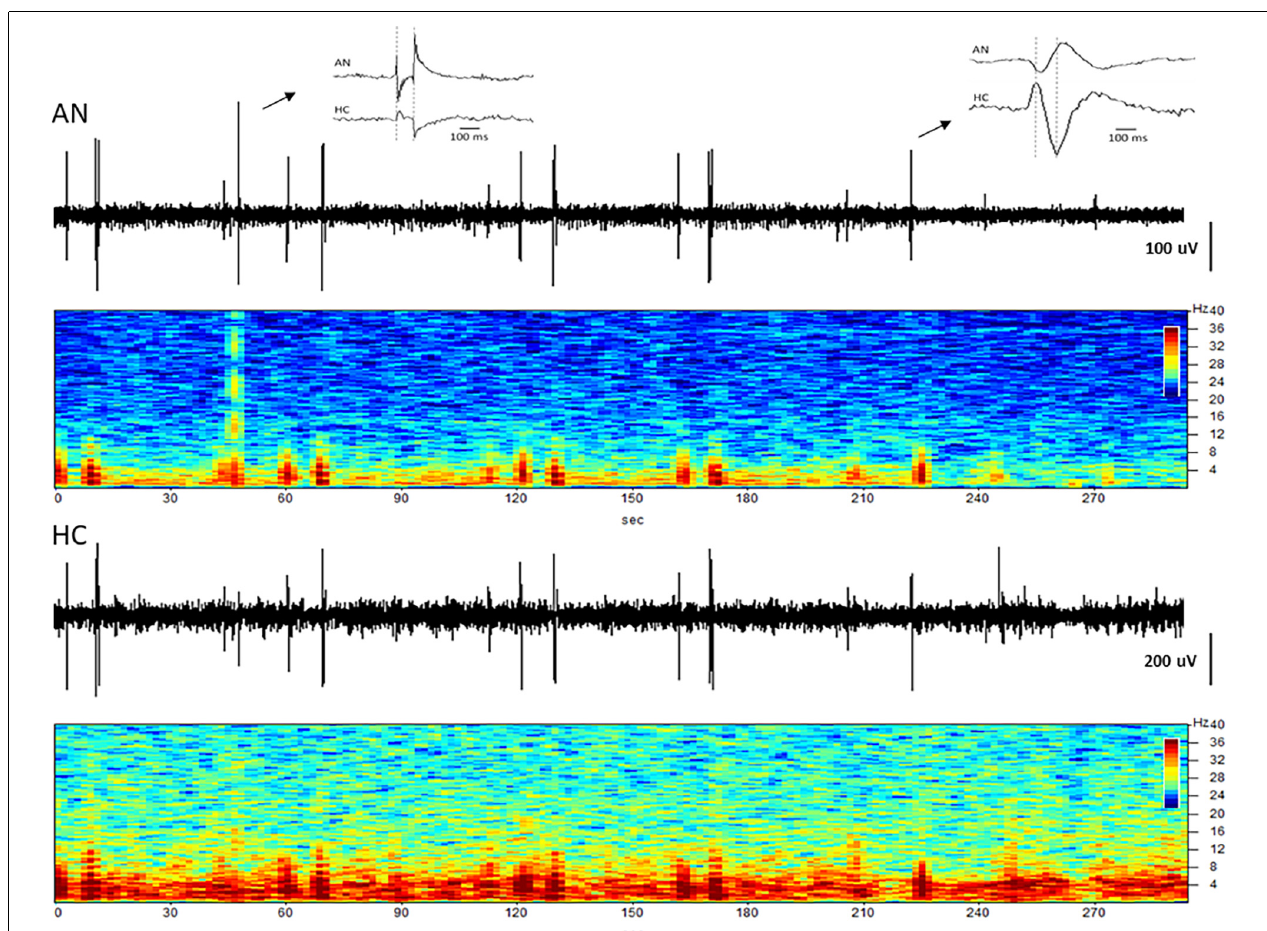
FIGURE 8 | Coupling between the hippocampus and anterior nucleus. Time domain and spectrograms from simultaneously recorded signals from the AN (top) and HC (bottom) in subject C3 (Year 4). Spike activity originating in the HC is recorded 30–40 ms later in the AN (right inset), consistent with evoked potential (EP) latency measures. The left inset shows a K-complex recorded as a large signal in the AN, but a small signal with no latency difference in HC, suggesting a far-field recording at that